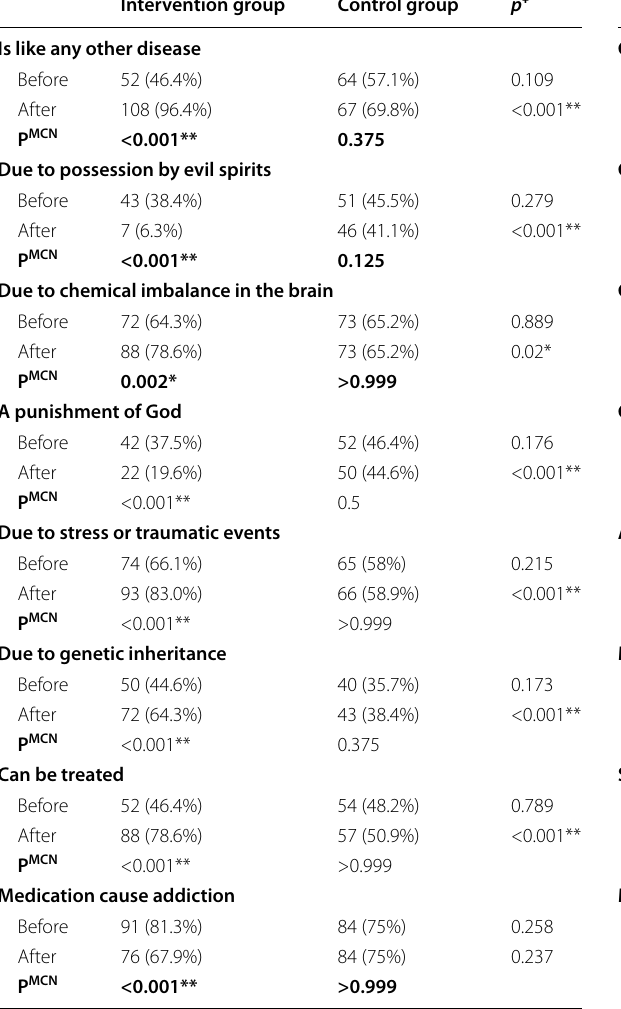
Table 4 Differences in attitude towards mental illness between intervention and control groups